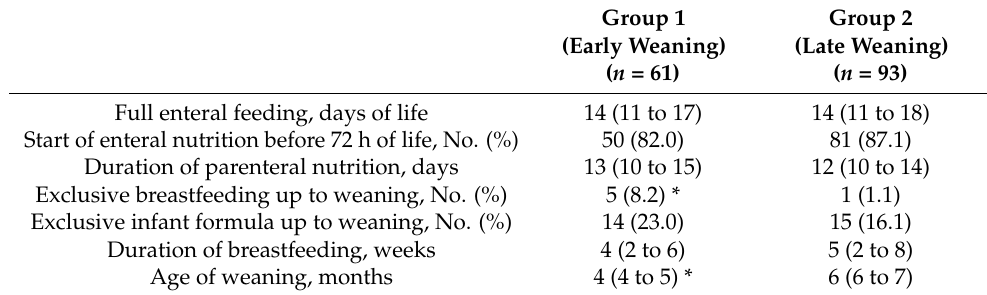
Table 3. Nutritional management of the study population.